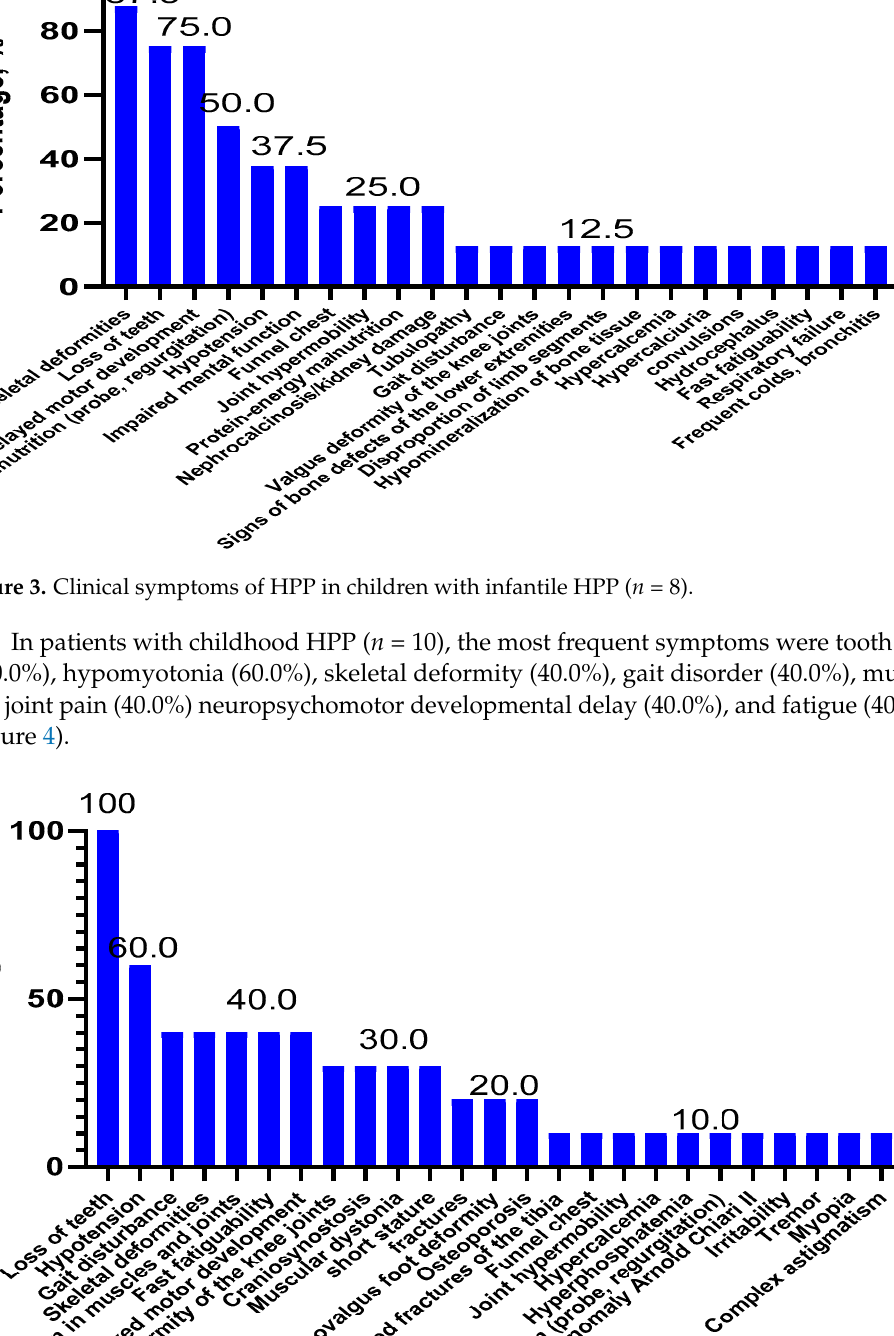
Table 2. Genetic variants of the ALPL gene in 27 compound heterozygotes and homozygotes HPP patients. Allele 1